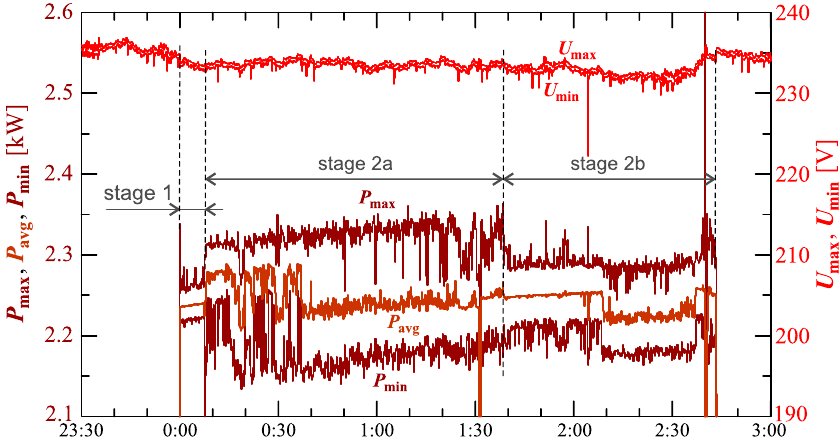
Figure 16. The characteristic of the maximum P max = f ( t ) , average P avg = f ( t ) , and minimum P min = f ( t ) values of the active power and maximum U max = f ( t ) and minimum U min = f ( t ) rms values of the supply voltage for Case